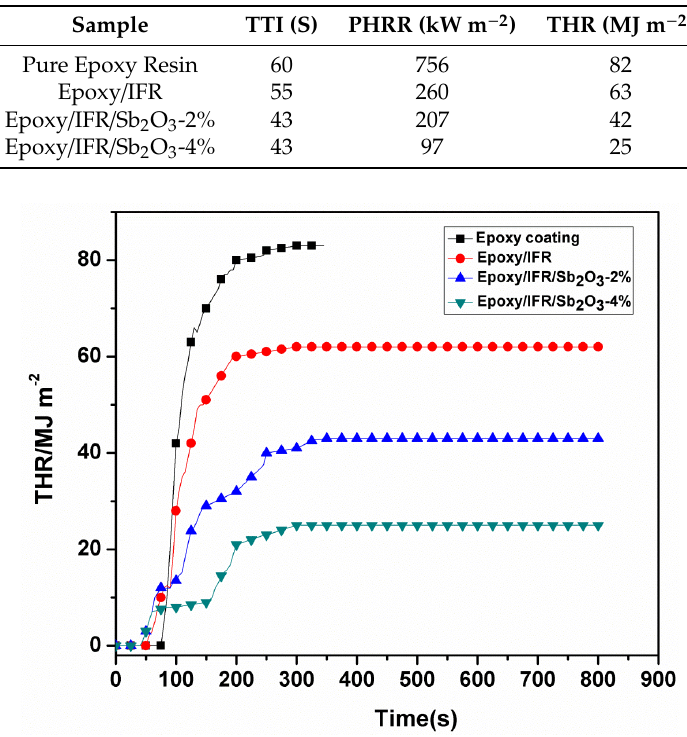
Figure 11. Total heat release (THR) curves of coatings.